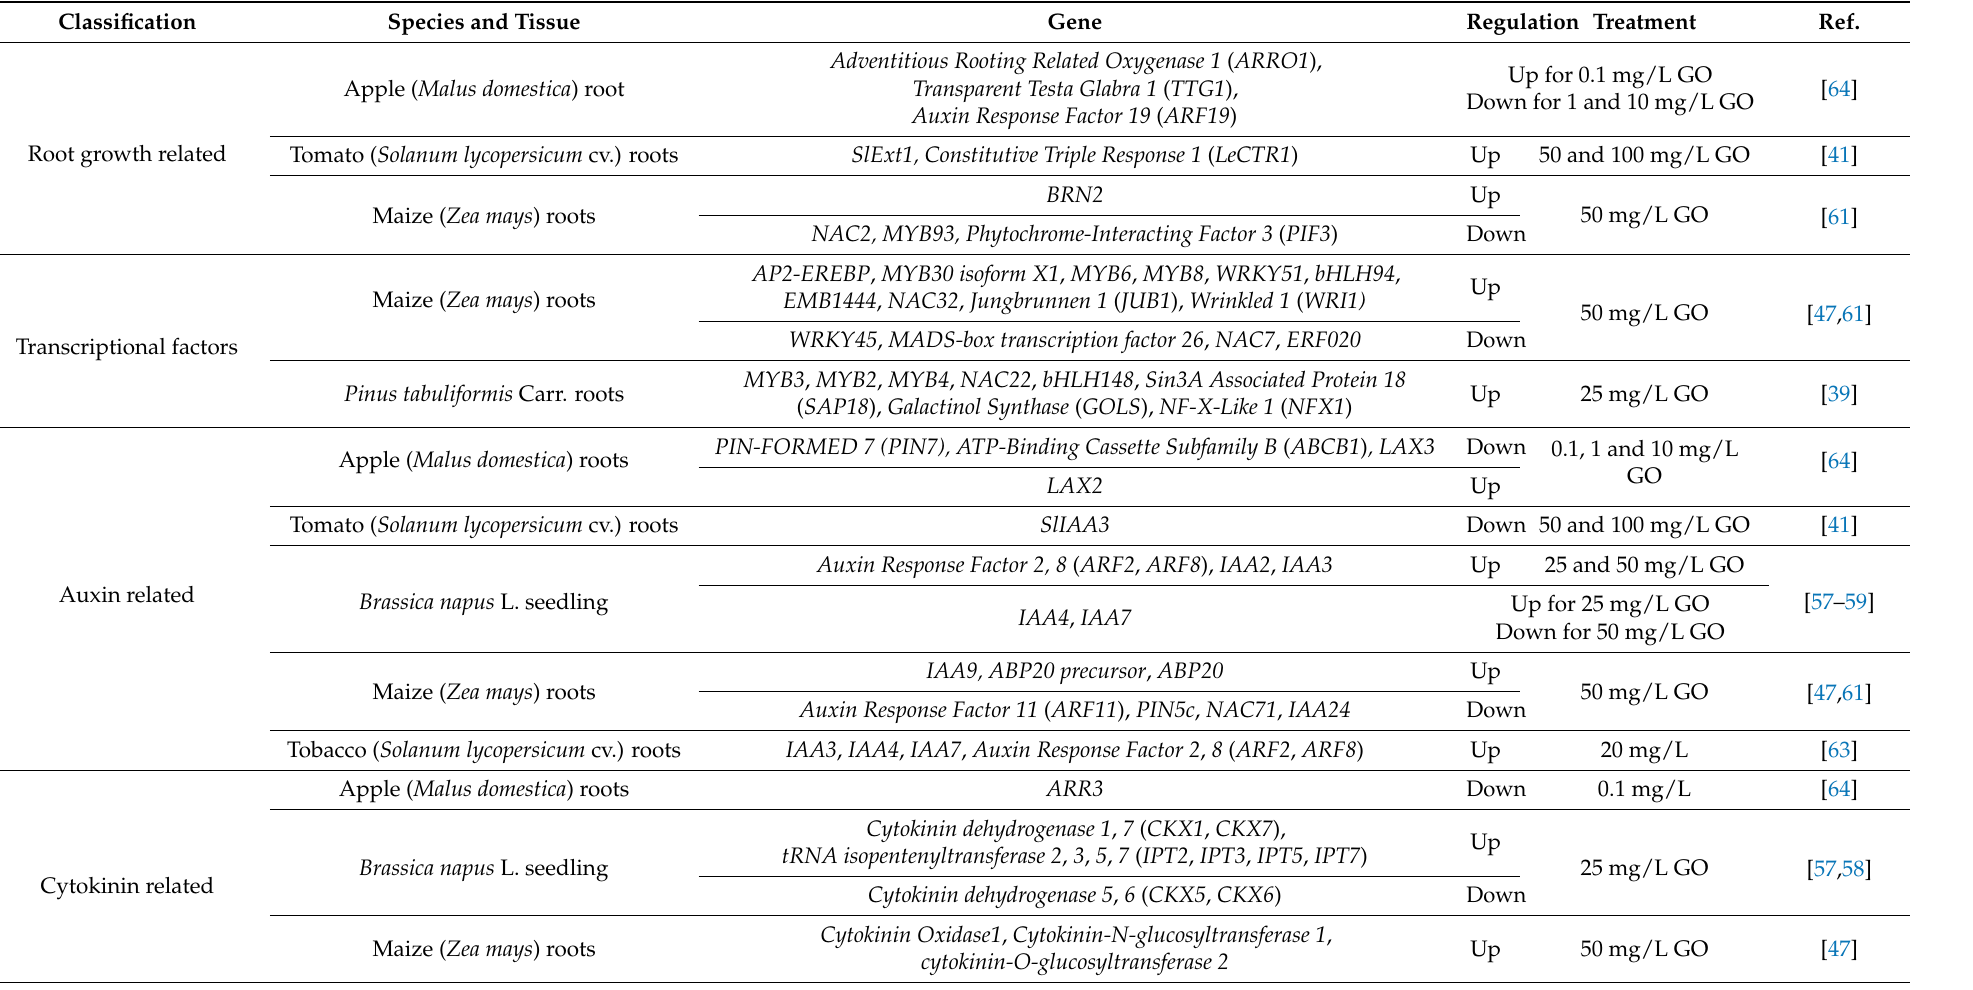
Table 3. Differentially expressed genes in response to GFNs treatment in